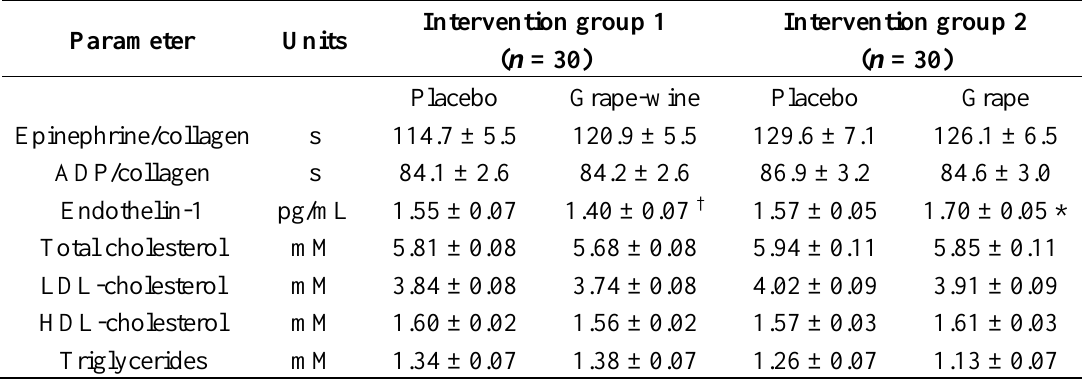
Table 3. The effect of grape-wine extract and grape extract on platelet aggregation time and plasma